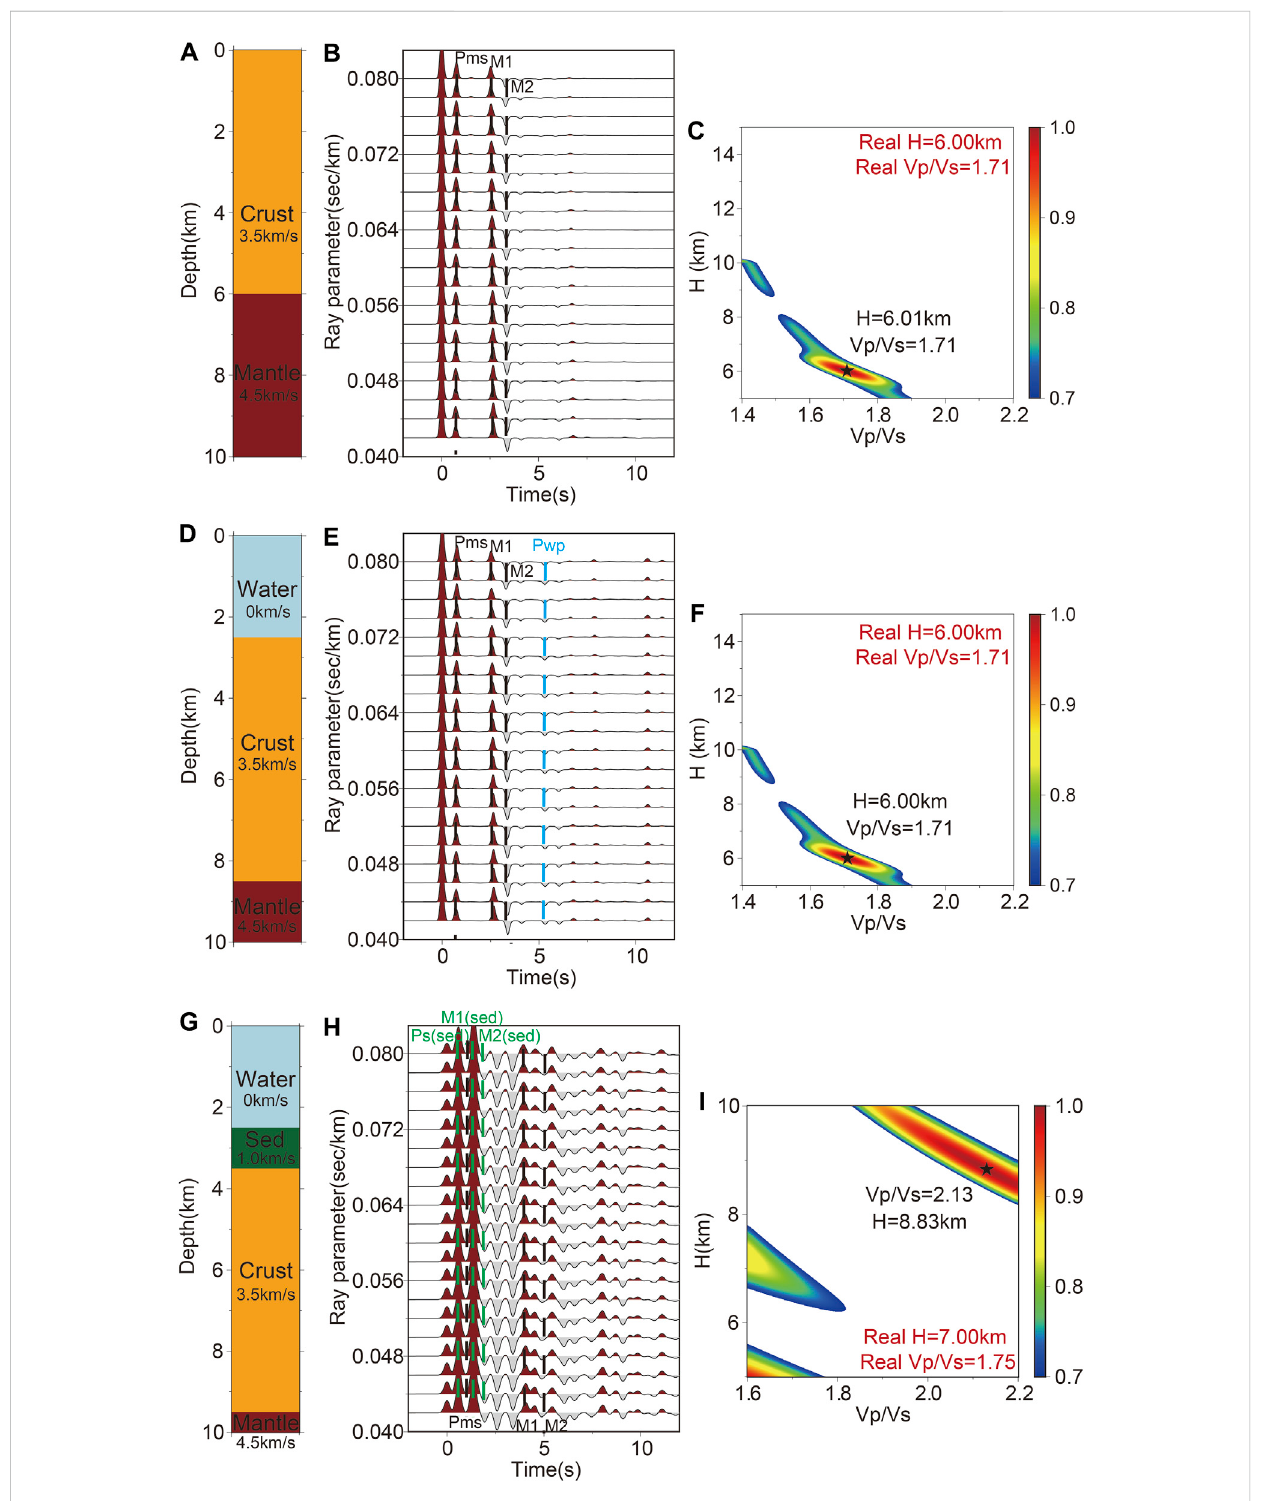
FIGURE 3 (A) , (D) , and (G) Crustal model. (B) , (E) , and (H) Synthetic receiver functions. (C) , (F) , and (I) H- κ stacking result.